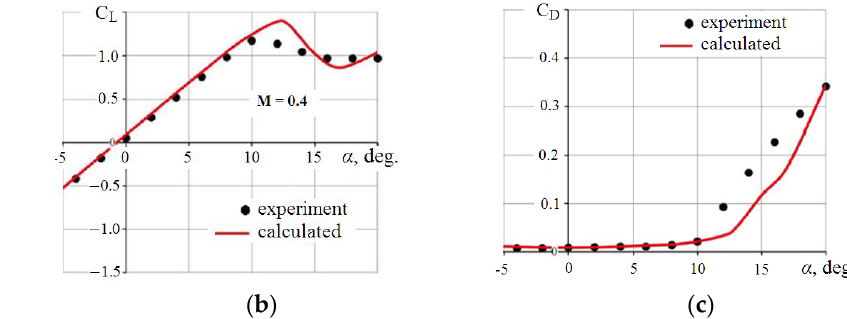
Figure 3. Comparing of calculated and experimental data: ( a )—drag force coefficient vs. Mach number: C D = f(M); ( b )—lift force coefficient vs. pitch angle C L = f(α); ( c )—drag force coefficient vs. pitch angle C D = f(α).